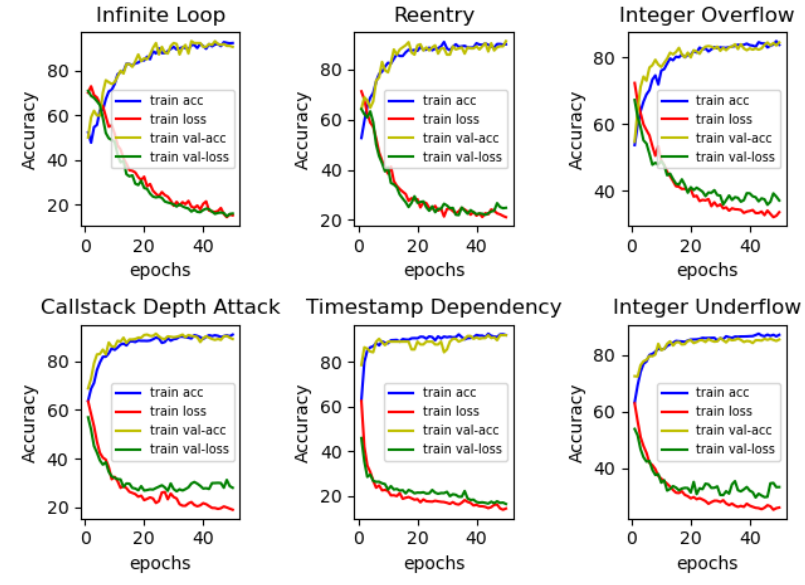
Figure 11. CBGRU model training process. Table 3. Test results for the six different vulnerabilities.